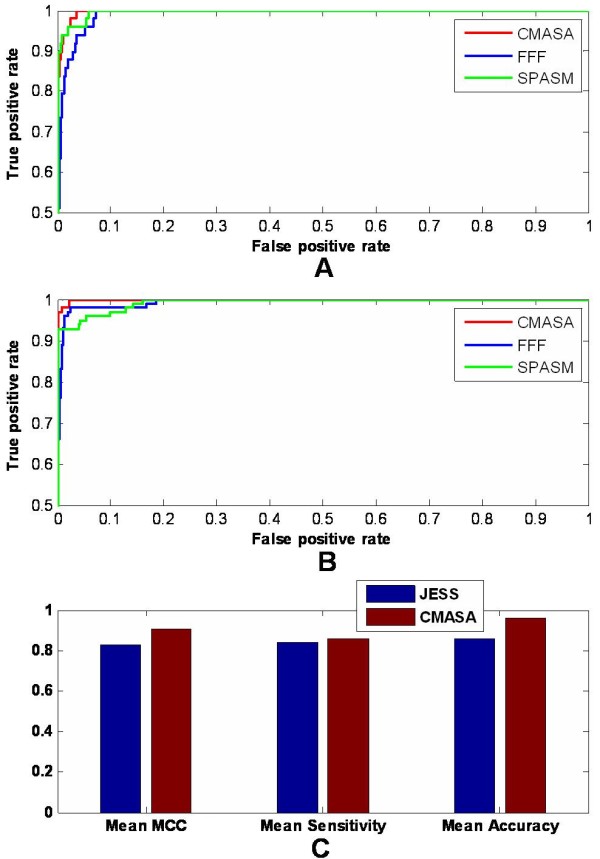
CMASA compare with FFF, SPASM and JESS. A. The ROC curve of the CMASA, the FFF and the SPASM using the 1aaz active site (C14, C17 and P66) searching to the nrSCOP. B. The ROC curve of the CMASA, the FFF and the SPASM using the 1mct active site (H57, D102 and S195) searching to the nrSCOP. C. The overall performance between the CMASA and the JESS.